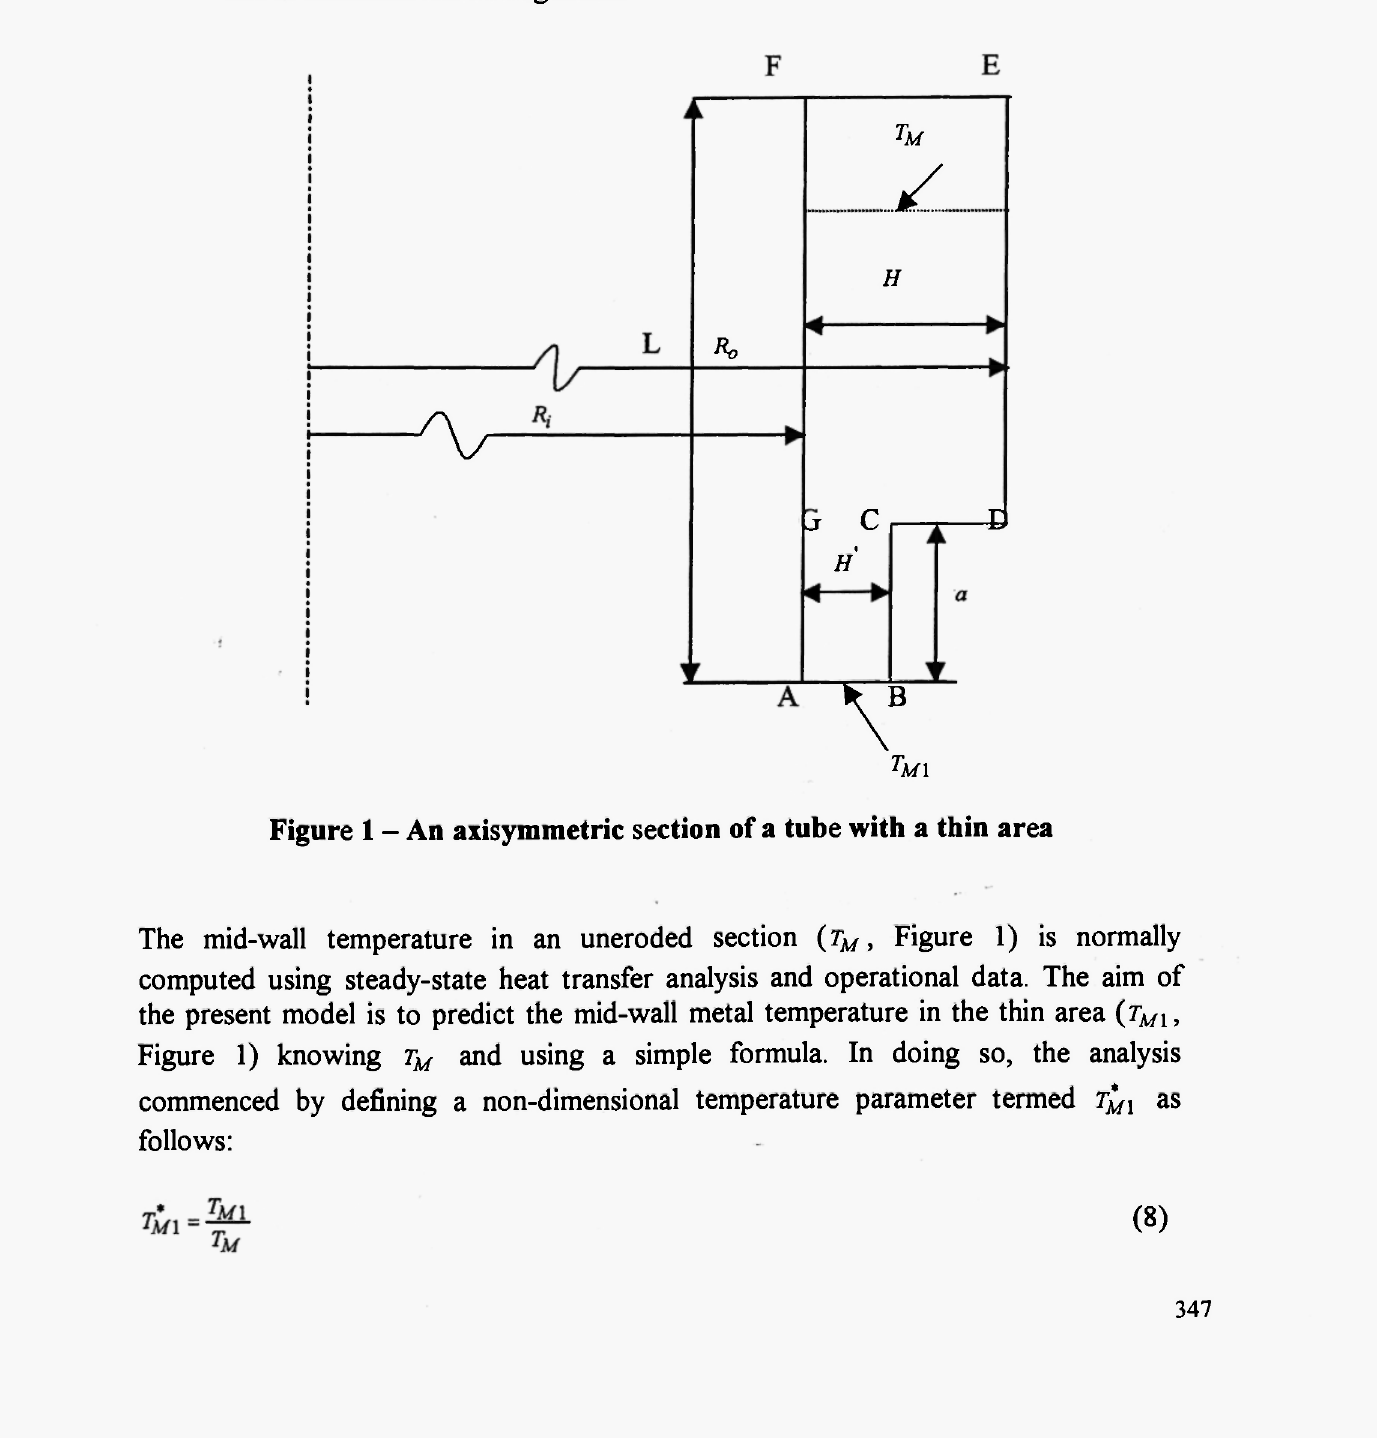
Figure 1 - An axisymmetric section of a tube with a thin area